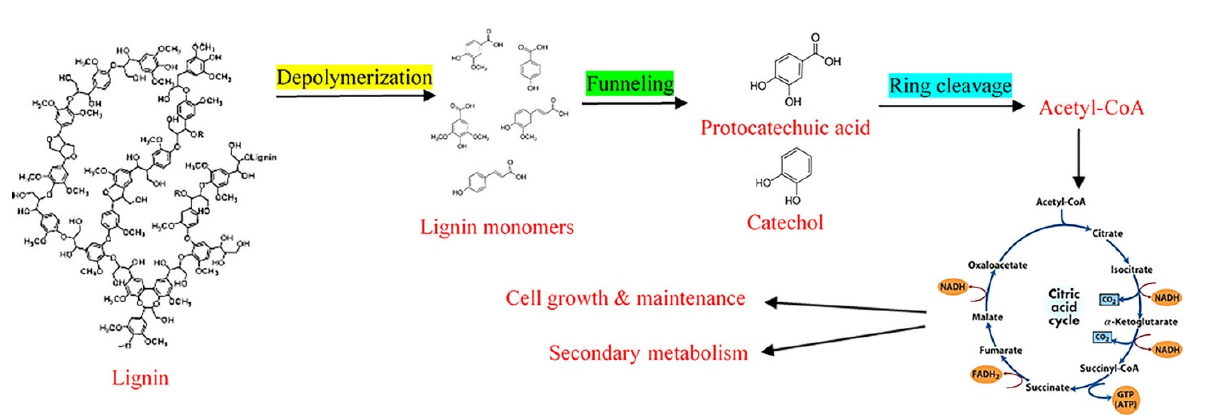
Figure 3. Production of value-added products from lignin after microbial degradation [9]. Copyright 2021 by John Wiley and Sons.